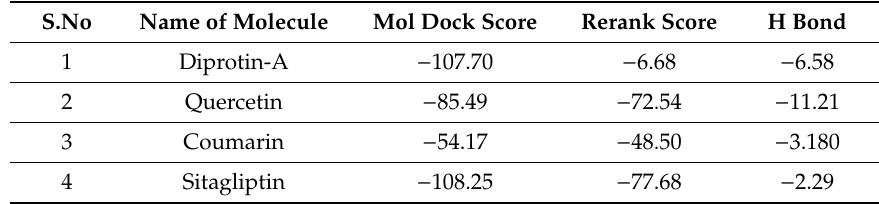
Table 1. The MolDockscore, rerank score, and hydrogen bond interaction energy of the di ff erent molecules with Dipeptidyl